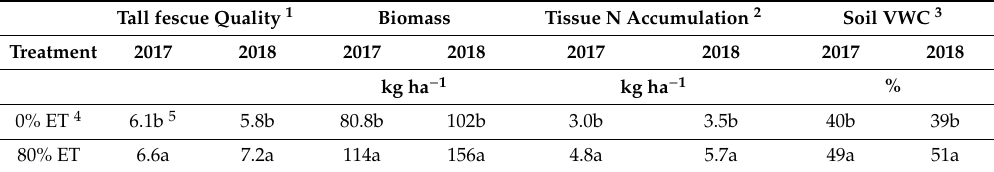
denoted with “cc” were calculated by the hyperspectral radiometer. Table 4. Irrigation strategies e ff ects on turfgrass biomass, leaf tissue N accumulation, and visual quality of tall fescue. Means reported are the average among the sampling dates for each year. Sampling was conducted between April and October for 2017 and between April and August of 2018. Tall fescue Quality 1